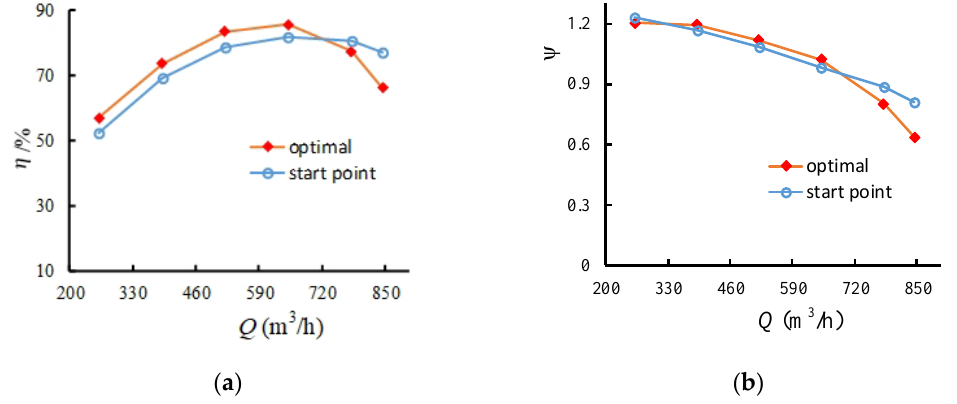
Figure 17. External characteristics of the optimal solution and optimal start point. ( a ) Efficiency comparison; ( b ) head